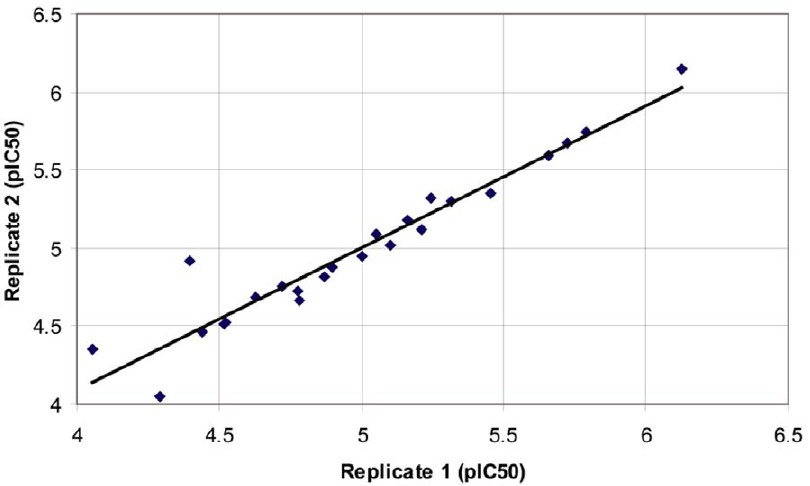
Figure 6. Replicate testing. Correlation between replicate pIC 50 values for each of the 24 compounds advanced to potency testing. Linear regression of these data returned a correlation coefficient of 0.92.